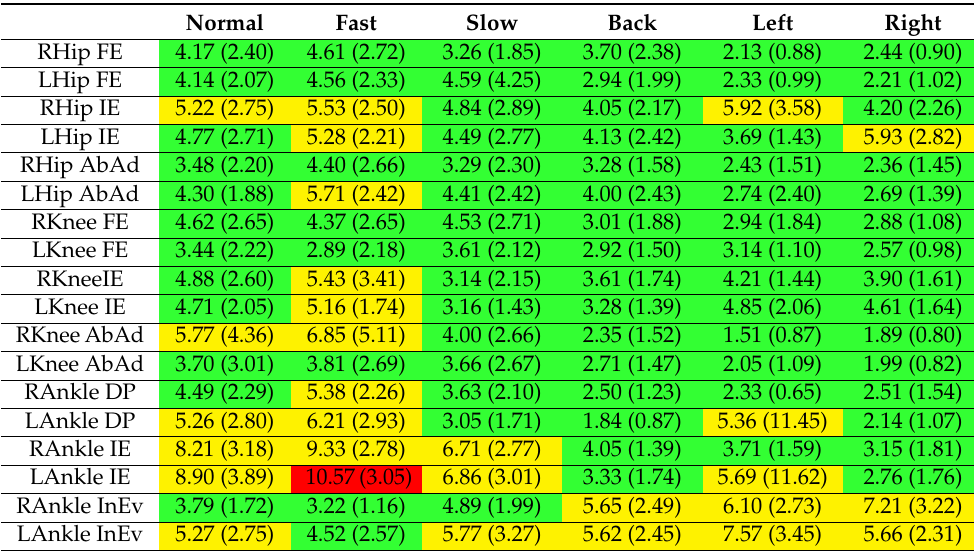
Table 5. Comparisons of range of motion with Inverse Kinematics Method. Mean (Standard De- viation) of RMS difference (IMU-IK) in range of motion estimates. All angles in degrees. Green, yellow, and red highlights indicate mean values < 5 deg, <10 deg, and ≥ 10 deg, respectively. Re- sults segmented by type of walking gait; namely normal forward (Normal), fast forward (Fast), slow forward (Slow), backward (Back), lateral left (Left), and lateral right (Right). Joint angles are flexion/extension (FE), internal/external rotation (IE), abduction/adduction (AbAd), dorsiflex- ion/plantarflexion (DP), and inversion/eversion (InEv). R and L prepended to joint names indicate right and left side, respectively.